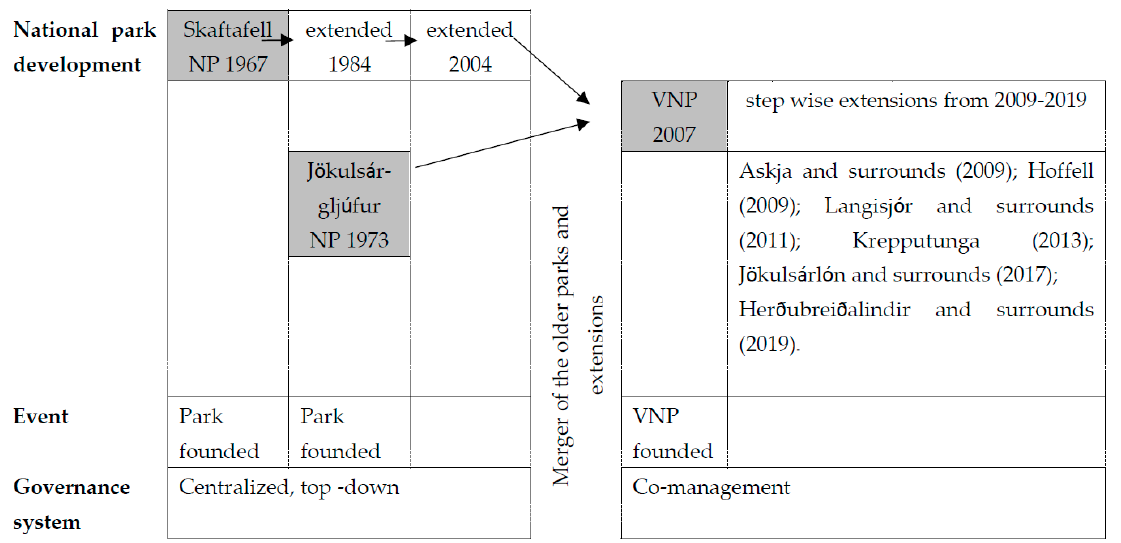
Figure 3. The development process of Vatnajökull National Park (VNP) and its